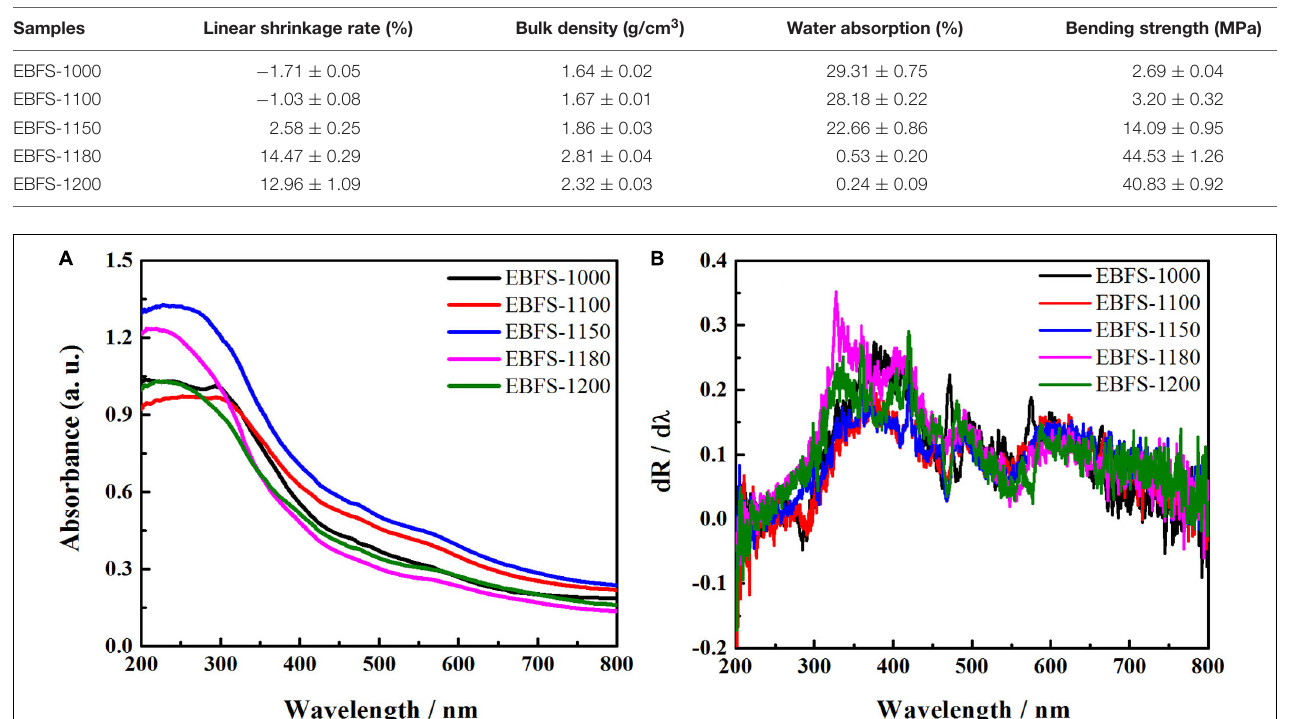
TABLE 4 | Physical properties of EBFS ceramics.